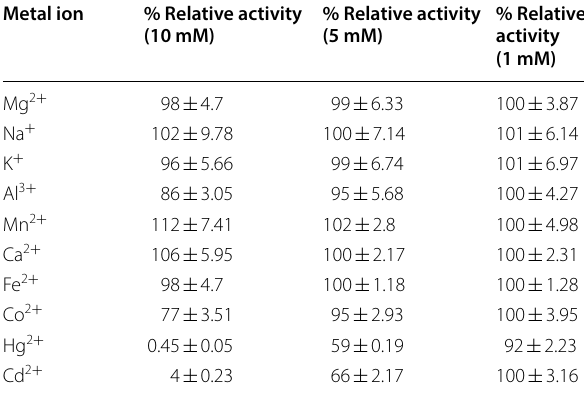
Table 2 Effect of the presence of metal ions on AMG activity